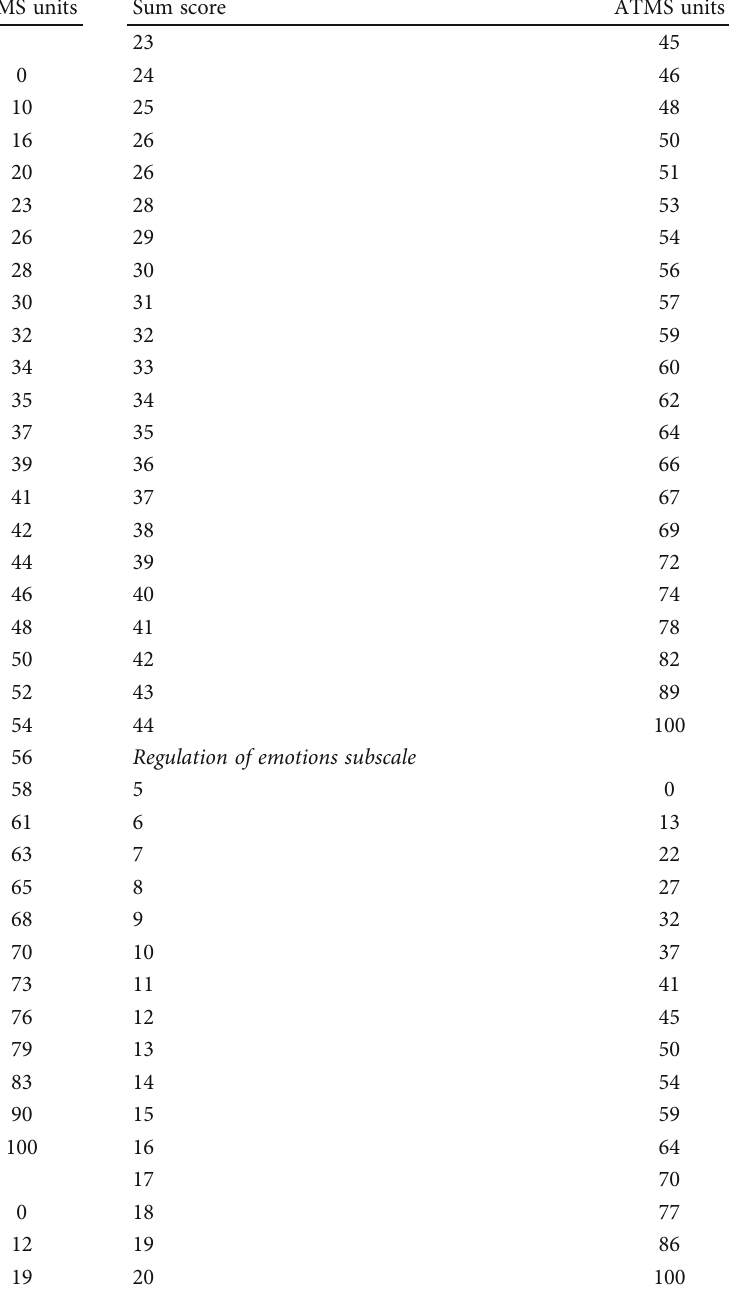
Table 4: Conversion table from sum score to ATMS units. Table 4: